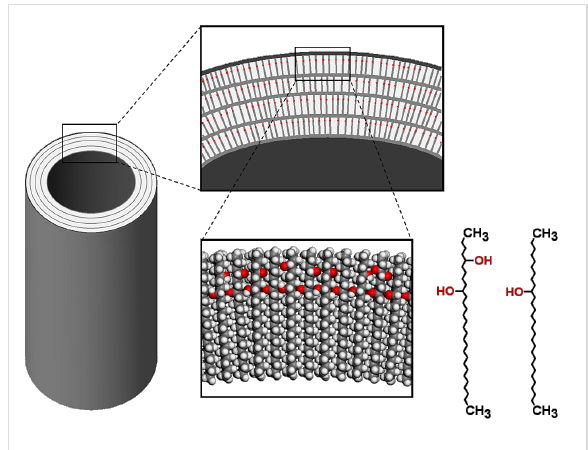
Figure 13: Model of a wax tubule composed of layers of nonacosan- 10-ol and nonacosanediol molecules. The OH-groups (red) occupy additional space so that the dense package is disturbed and the layer is forced into a curvature which leads to the formation of a tubule. The polar OH-groups are hidden in the layer, only the CH 3 -groups appear at the surface of the layers and